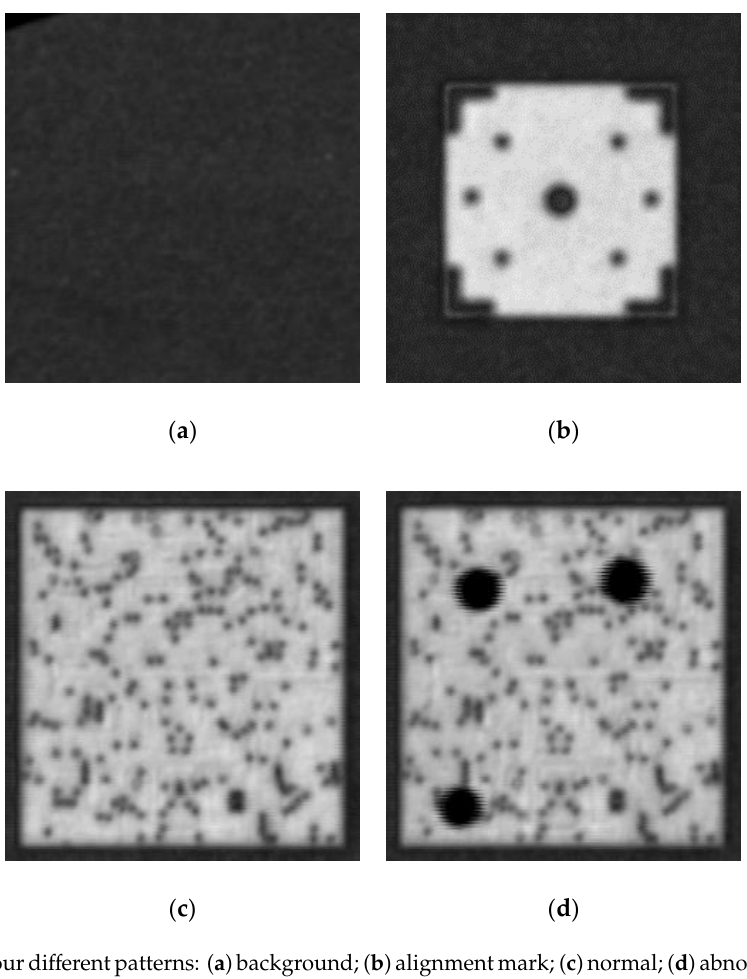
Figure 9. Initial wafer mapping result from detected and predicted die patterns.